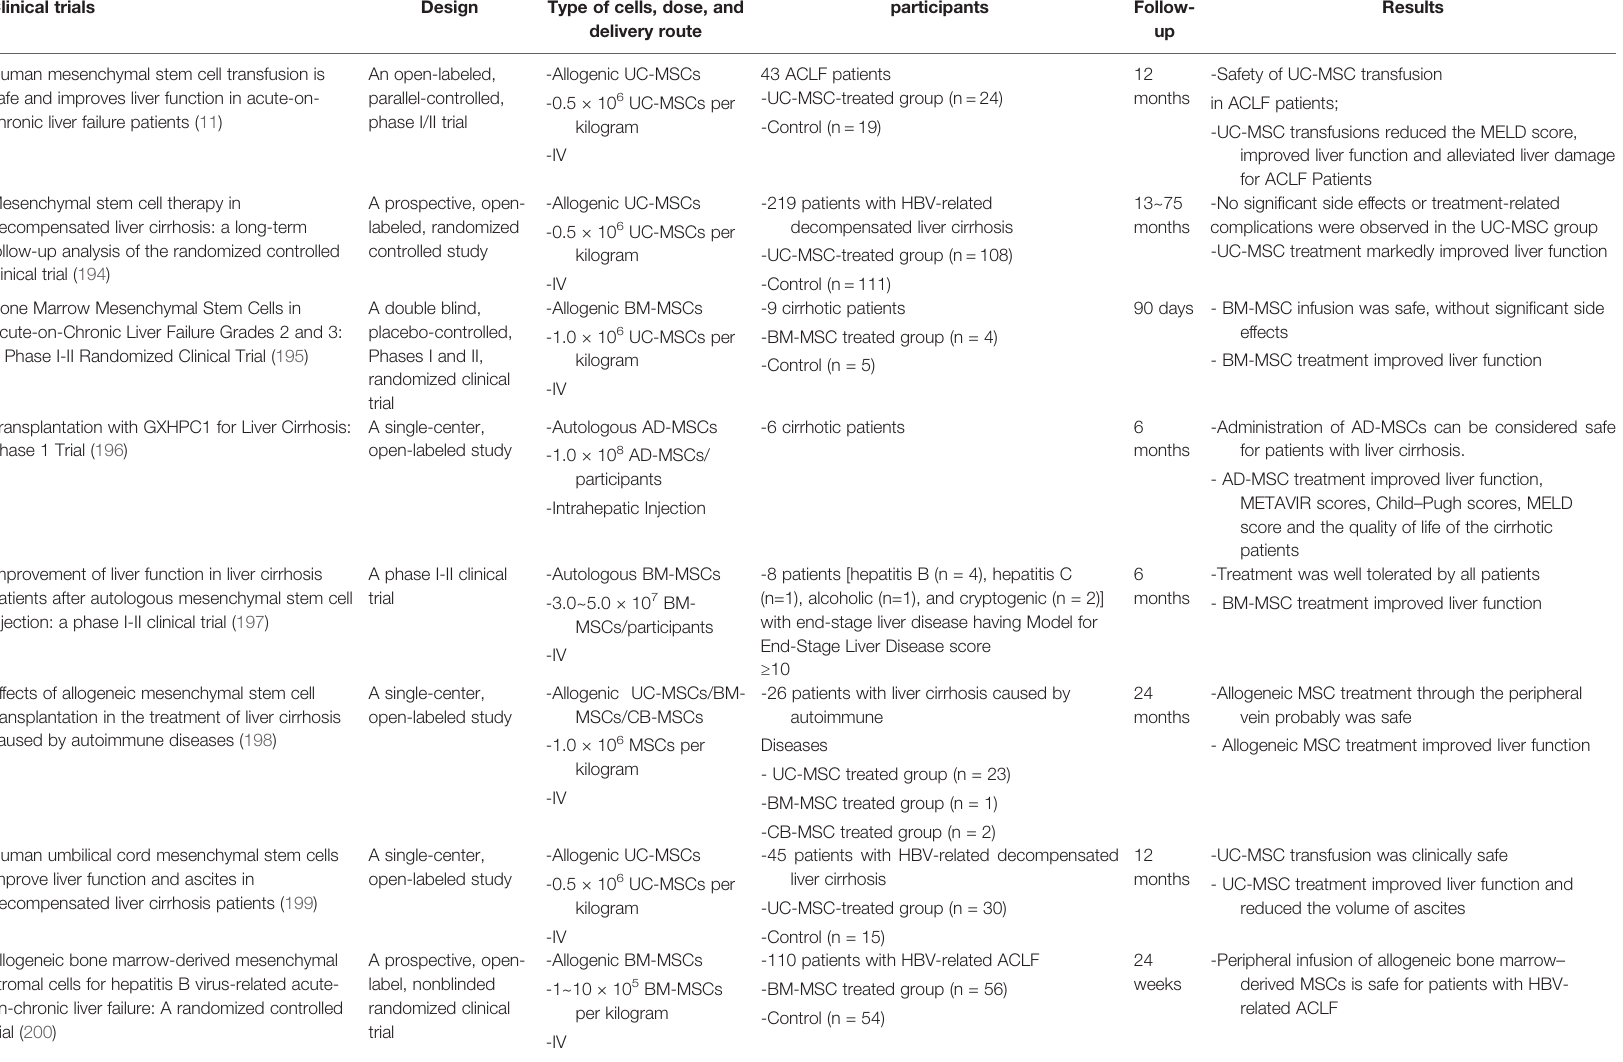
TABLE 2 | Clinical safety and ef fi cacy of MSC therapy in liver